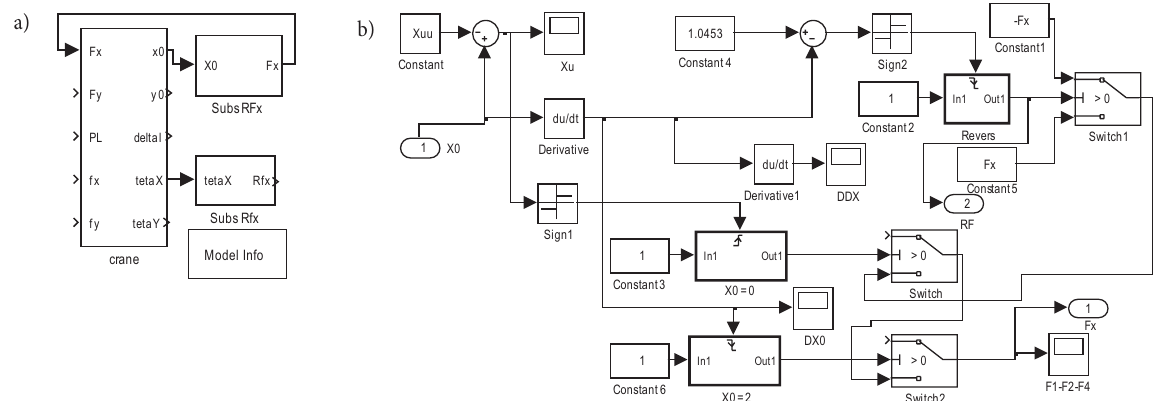
Fig. 4. Model K1 and control